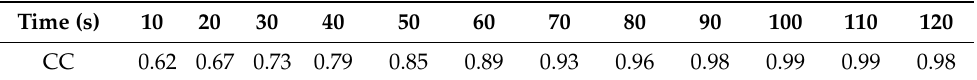
Table 3. Correlation coefficient between root depths and average temperature of upper surface during the cooling